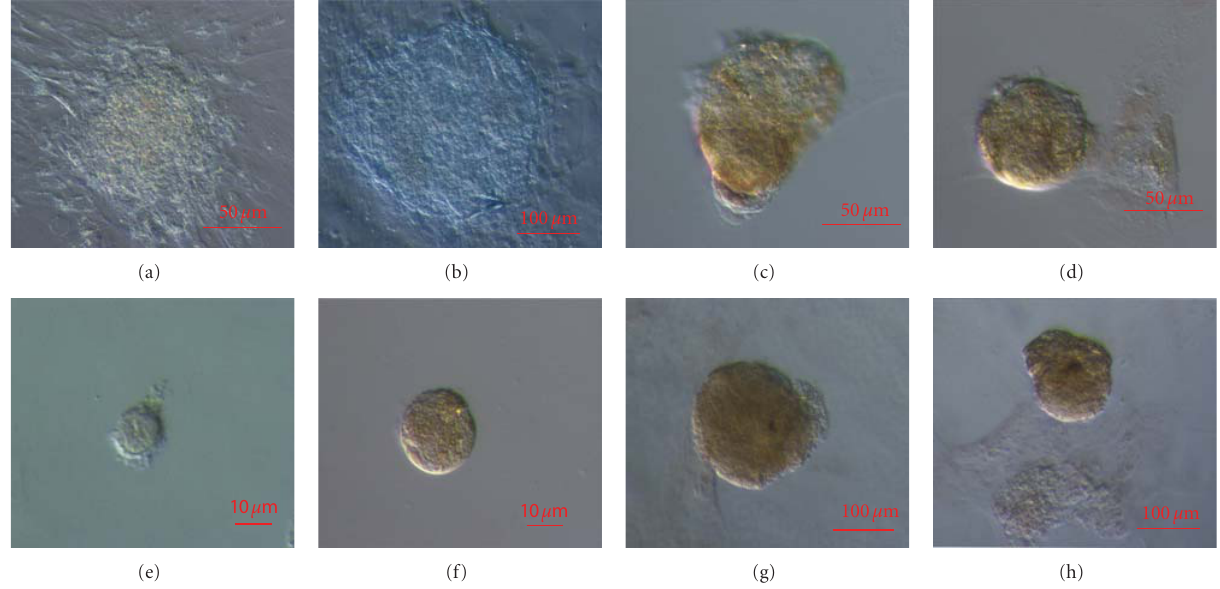
Figure 8: Immunocytochemical staining of cell clusters and oocyte-like cells developed during the in vitro culture of cells scraped from the ovarian surface epithelium on markers of pluripotency SOX-2 and SSEA-4. (a, b) Non-stained cell clusters (negative control) (magnifications 40-times and 100-times). (c, d). Cell clusters positively (brown) stained on SOX-2 (magnification 40-times). (e) SOX-2 non-stained round cell (negative control) (magnification 200-times). (f) Round cell positively (brown) stained on SOX-2 (magnification 200-times). (g, h) Cell clusters positively (brown) stained on SSEA-4 surface antigen (magnification 100-times). (Inverted microscope, Ho ff man